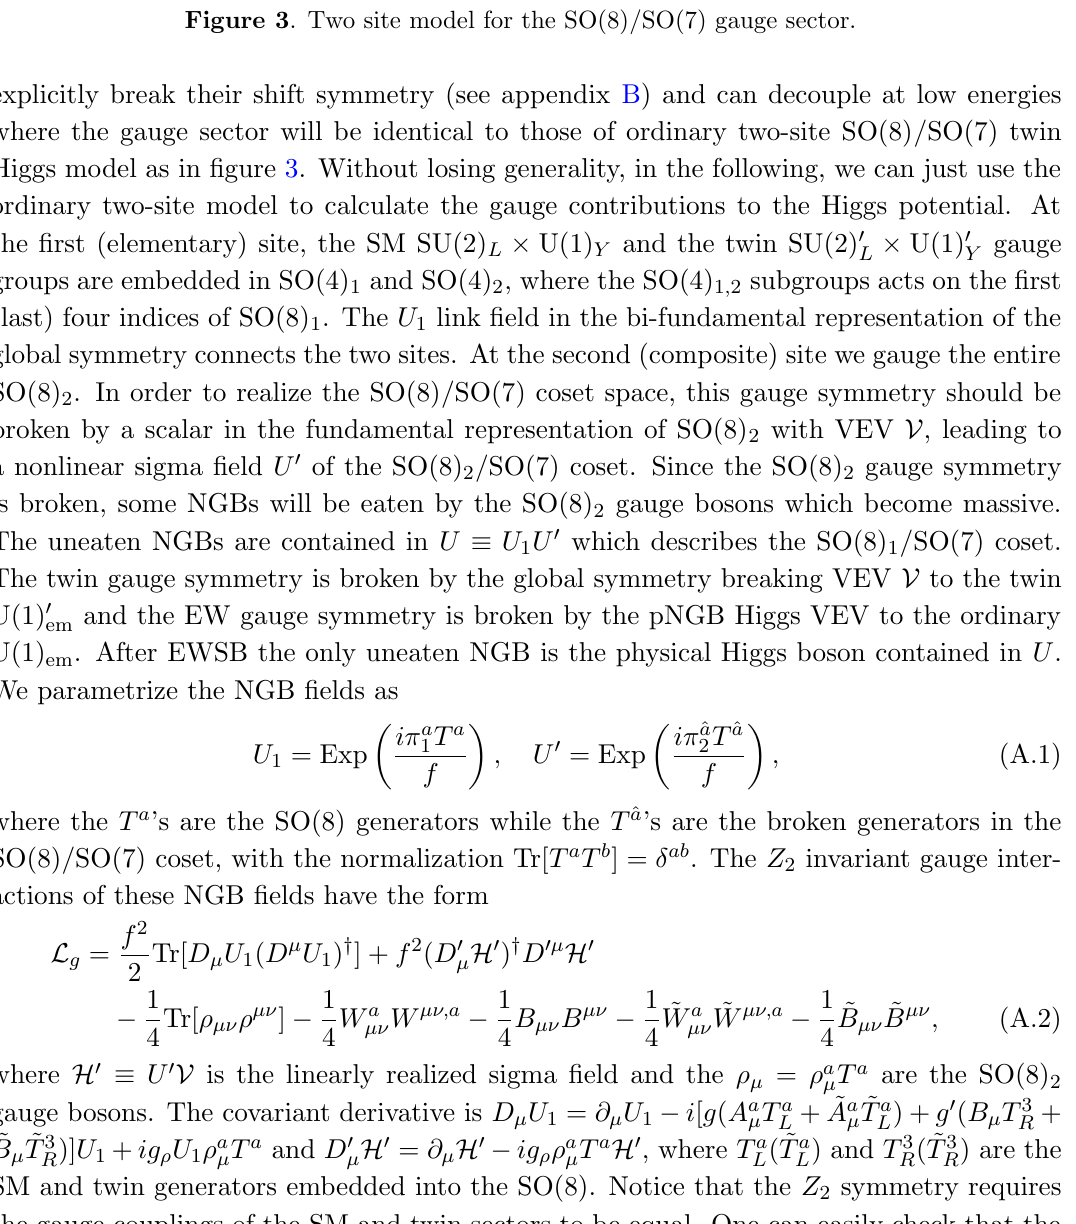
Figure 3 . Two site model for the SO(8) = SO(7) gauge